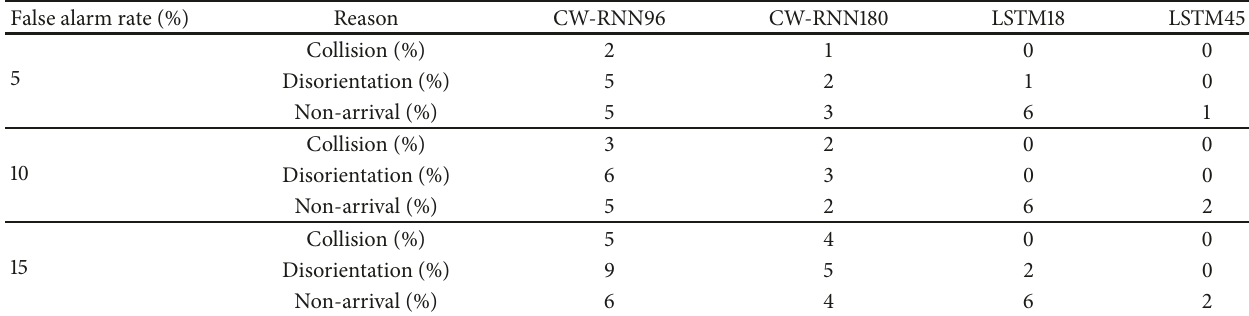
Table 3: The reasons for failure of obstacle avoidance planning in statistical